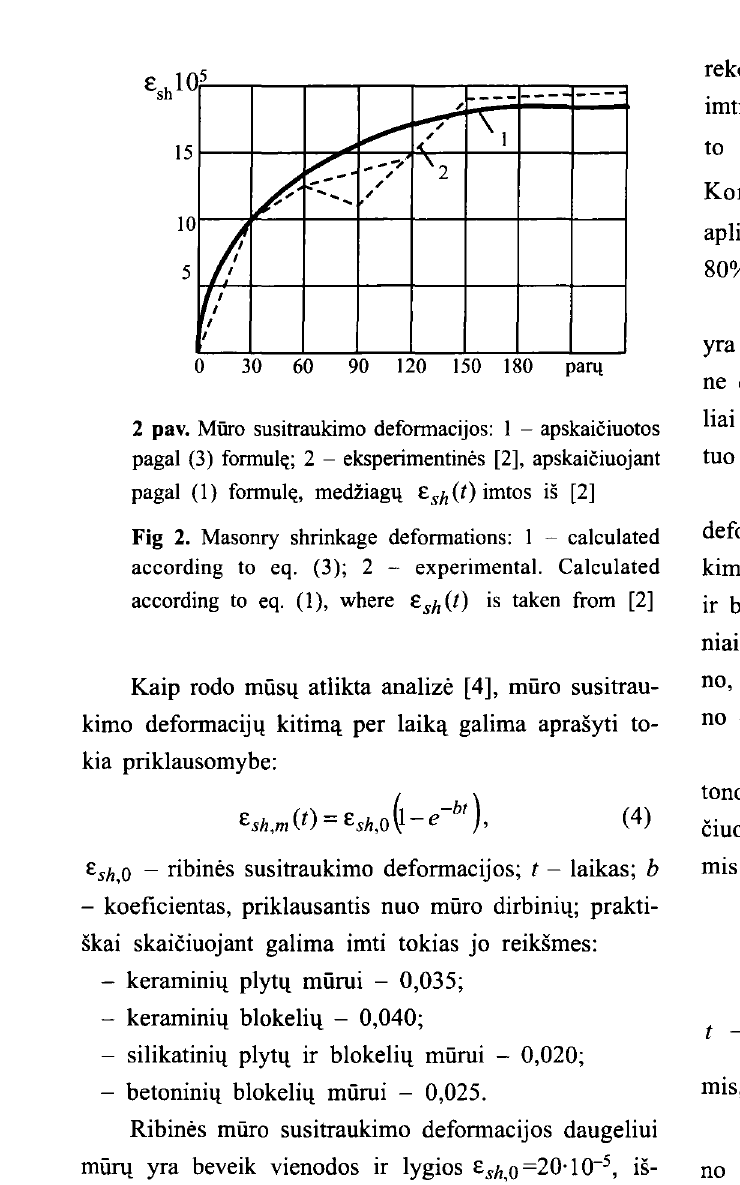
Fig 2. Masonry shrinkage deformations: 1 - calculated according to eq. (3); 2 - experimental. Calculated according to eq. (1), where £sh(t) is taken from [2]